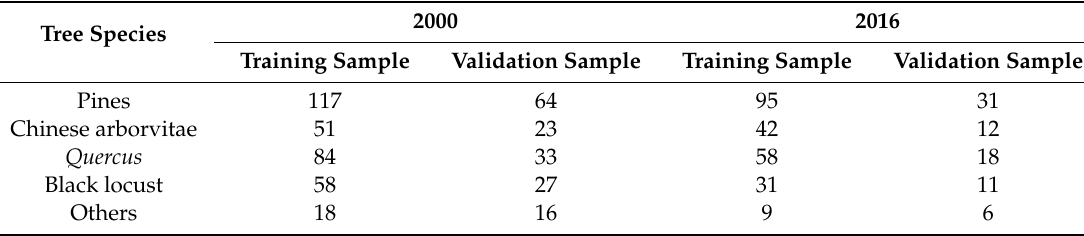
Table 2 classifies the sample data of 2000 and 2016. Table 2. Statistical table of sample number of each tree